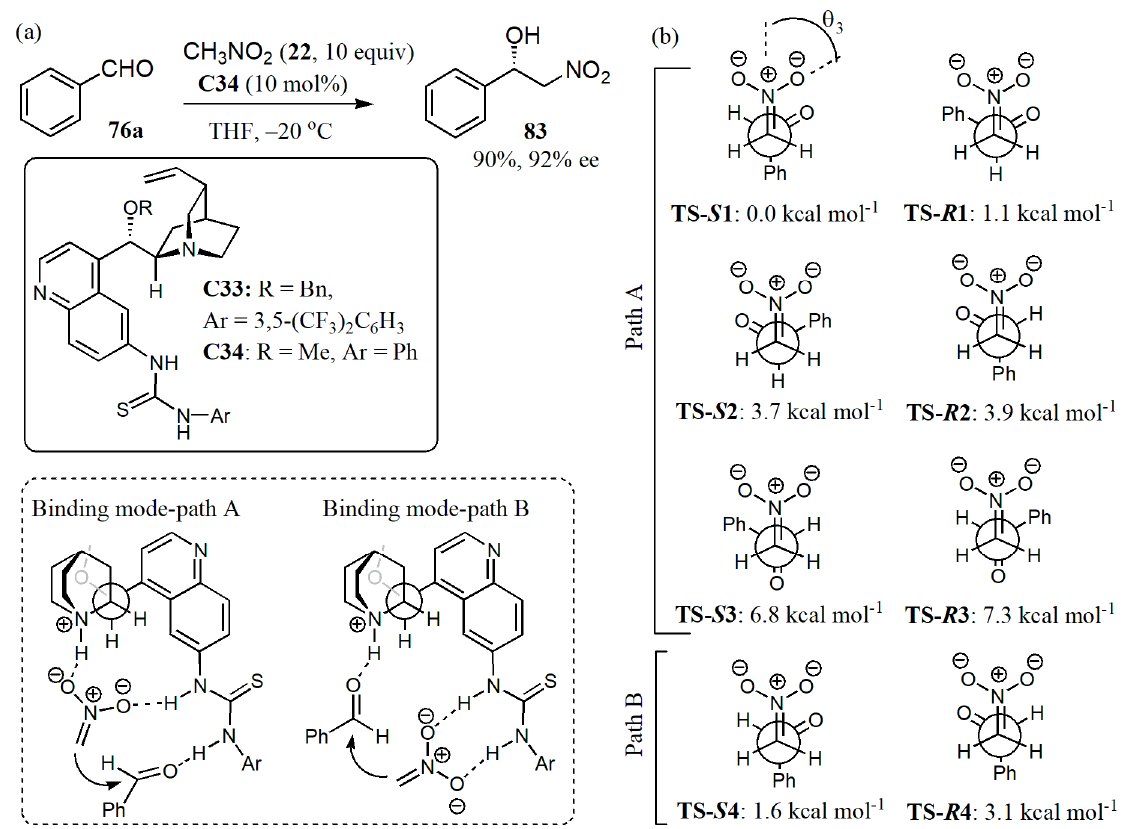
Figure 44. ( a ) Cinchona thiourea-catalyzed enantioselective Henry reaction; ( b ) Calculated relative transition state energies for C–C bond formation. Values include solvation effects [87,88].